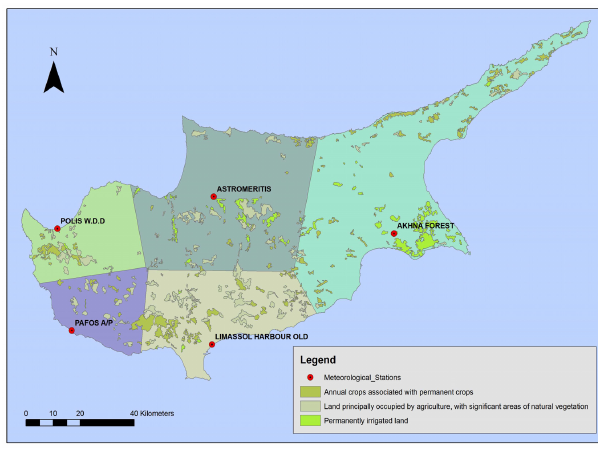
Fig 3. Cyprus division according to Thiessen methodology. Fig. 3. Cyprus division according to Thiessen